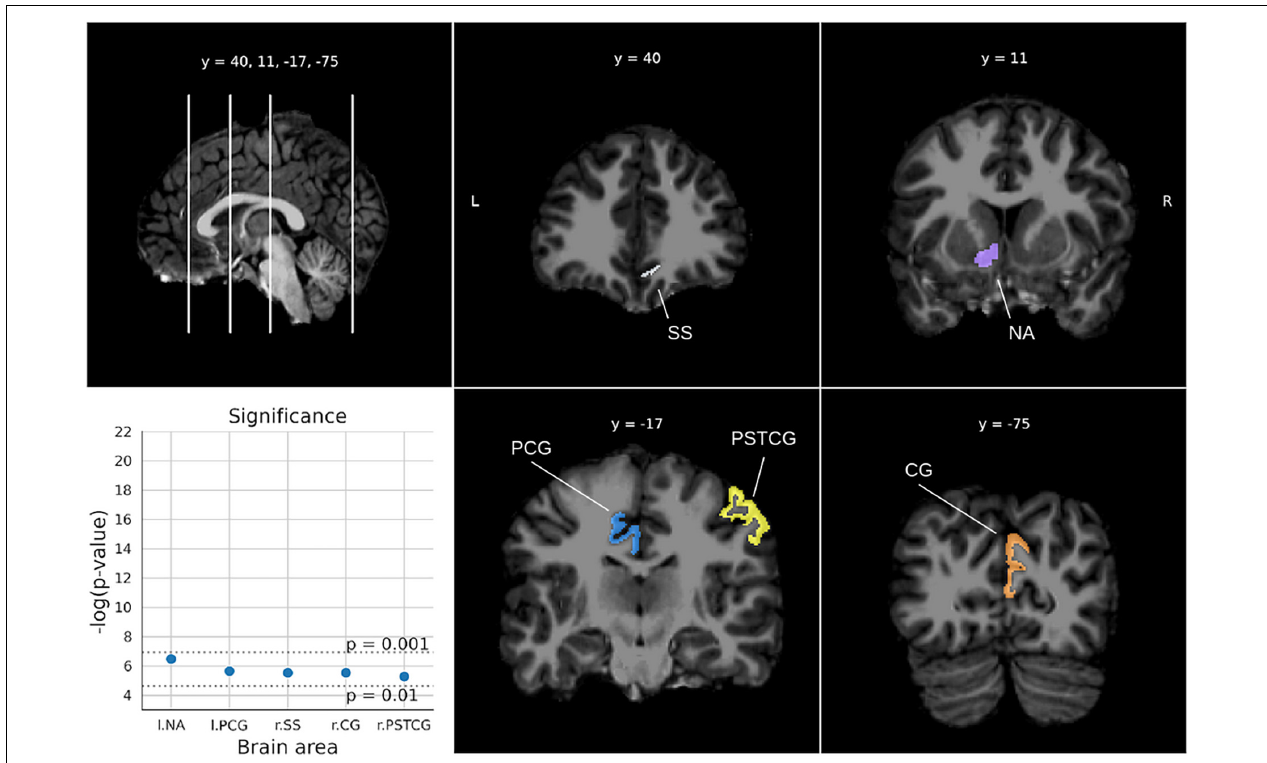
gyrus), PSTCG (Post-central